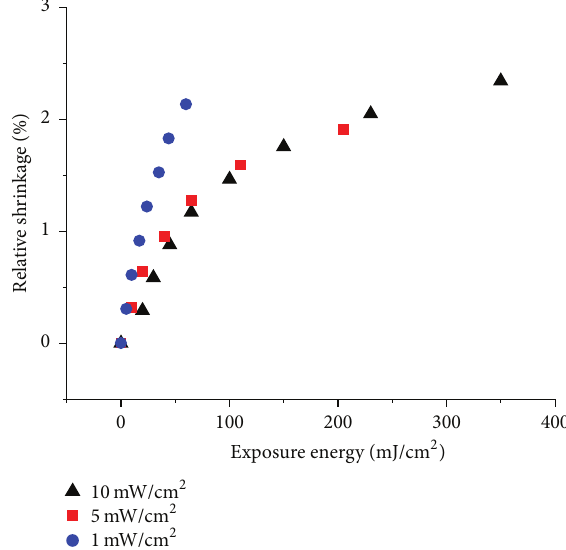
Figure 7: Relative shrinkage (%) versus exposure energy (mJ/cm 2 ) for gratings recorded in 120 𝜇 m DA photopolymer layers with recording intensities of 1, 5, and 10mW/cm 2